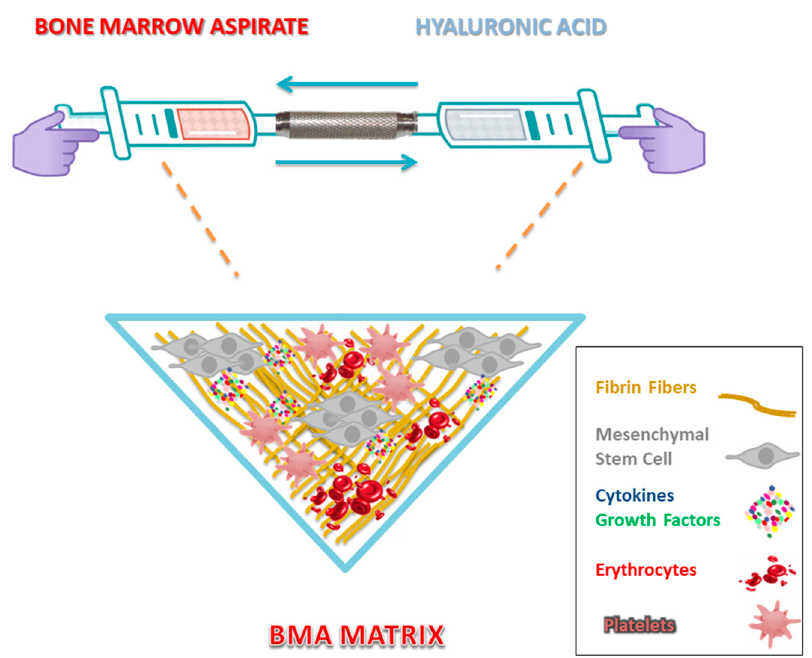
Figure 1. Bone marrow aspirate (BMA) Matrix. The combination of BMA with hyaluronic acid (HA) enables the formation of the BMA matrix, proposing a novel strategy towards the enhancement of regenerative mechanisms and possible syn- ergistic effects. The crosslinked fibrin fibers derived from the BMA clot form a natural scaffold, supporting cellular activity and reconstruction of damaged tissue.